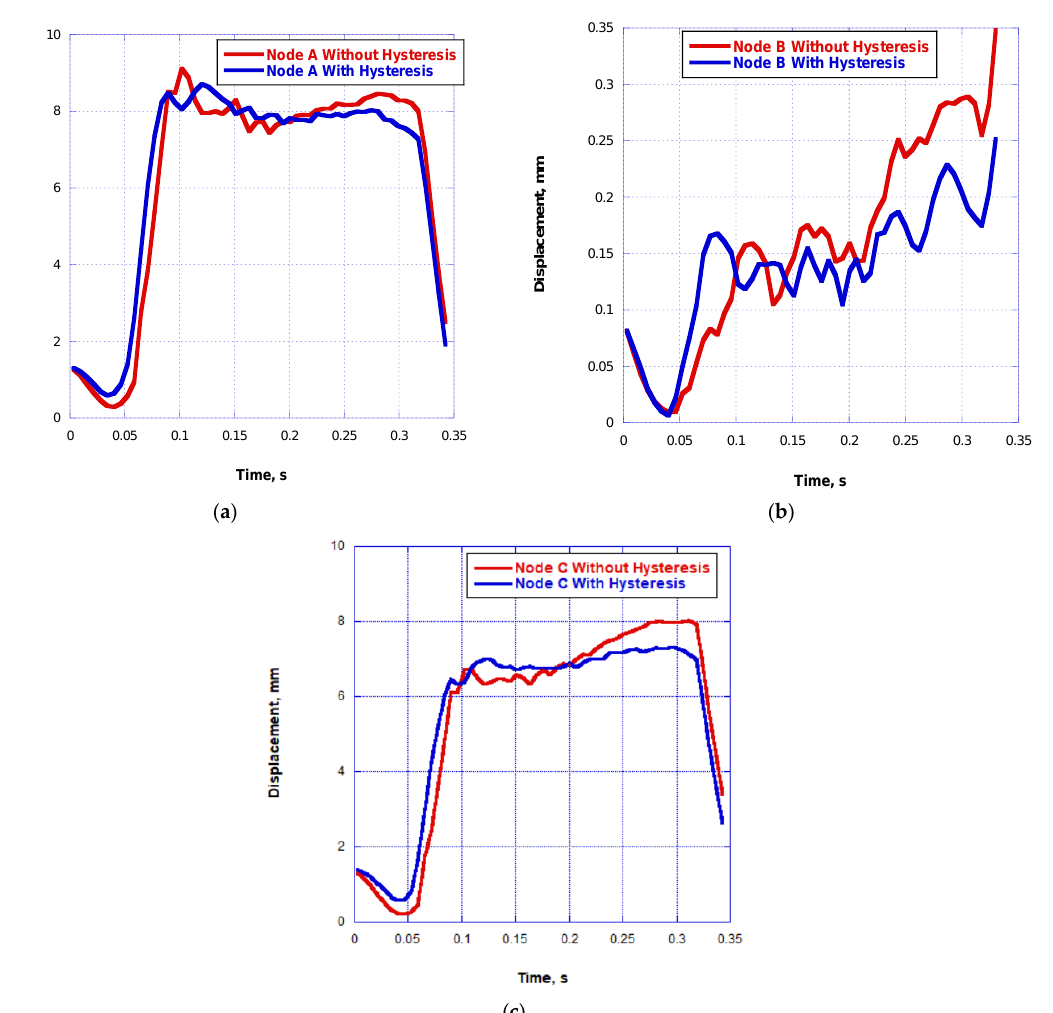
Figure 16. Time-variations of resultant displacement at three points with and without hysteresis. ( a ) Node A, ( b ) Node B, and ( c ) Node C.